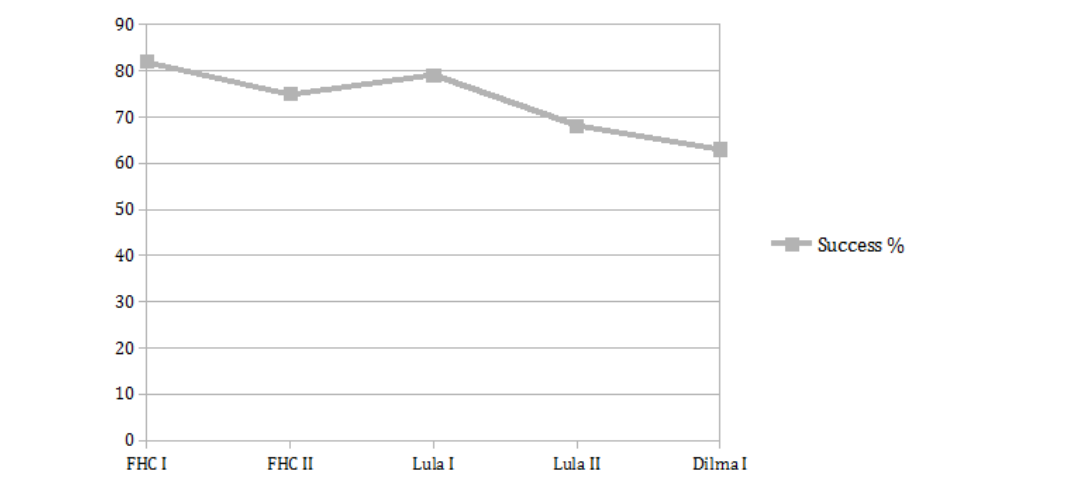
Figure 1: Rate of legislative success by government